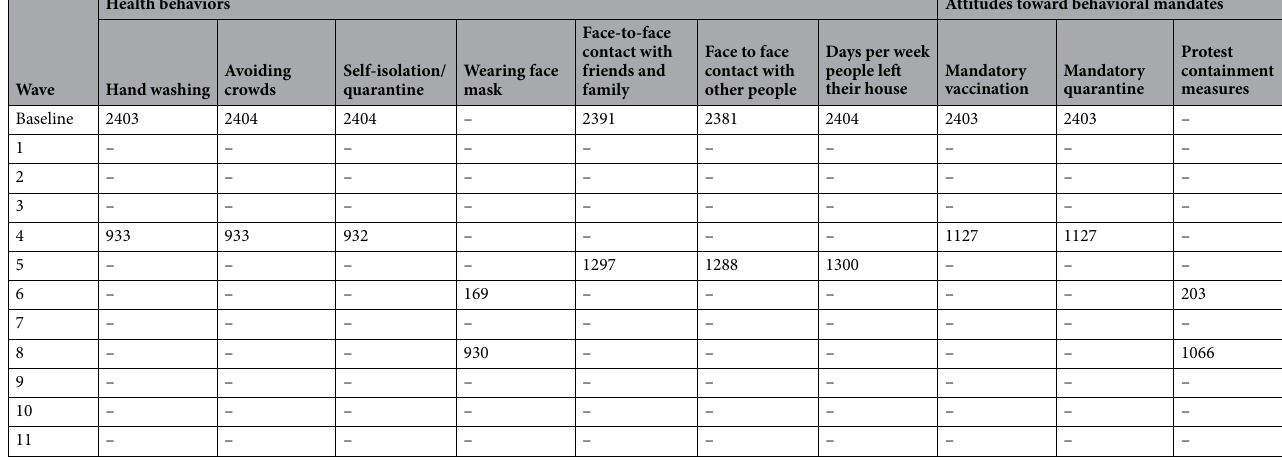
Table 5. Observations per time point for health behaviors and attitudes toward behavioral